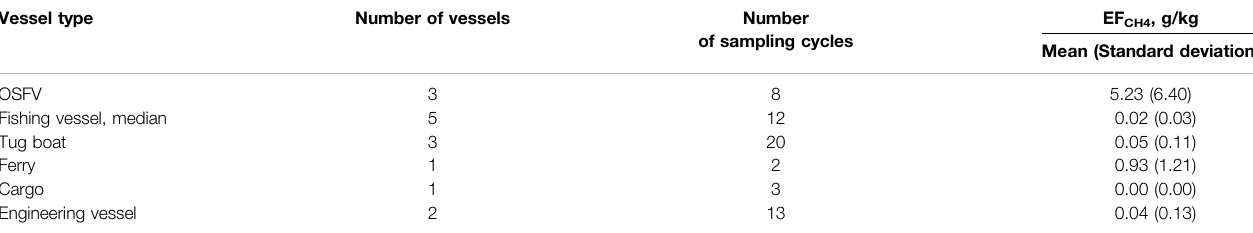
TABLE 1 | Integrated emission factors of methane (EF CH4 ) from different types of vessels measured in this study. Vessel type